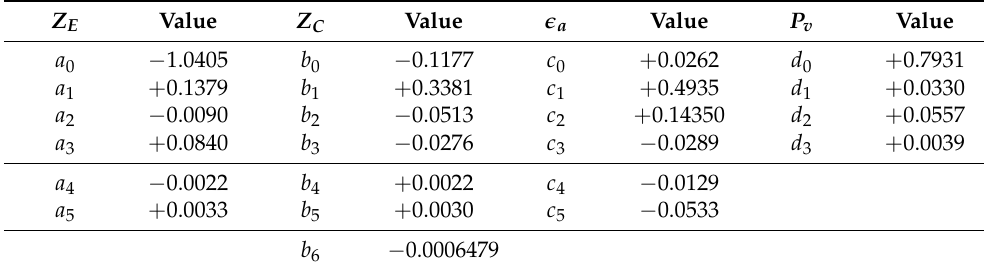
Table 1. Model’s coefficients to evaluate the system’s effectiveness and the power required by the refrigeration